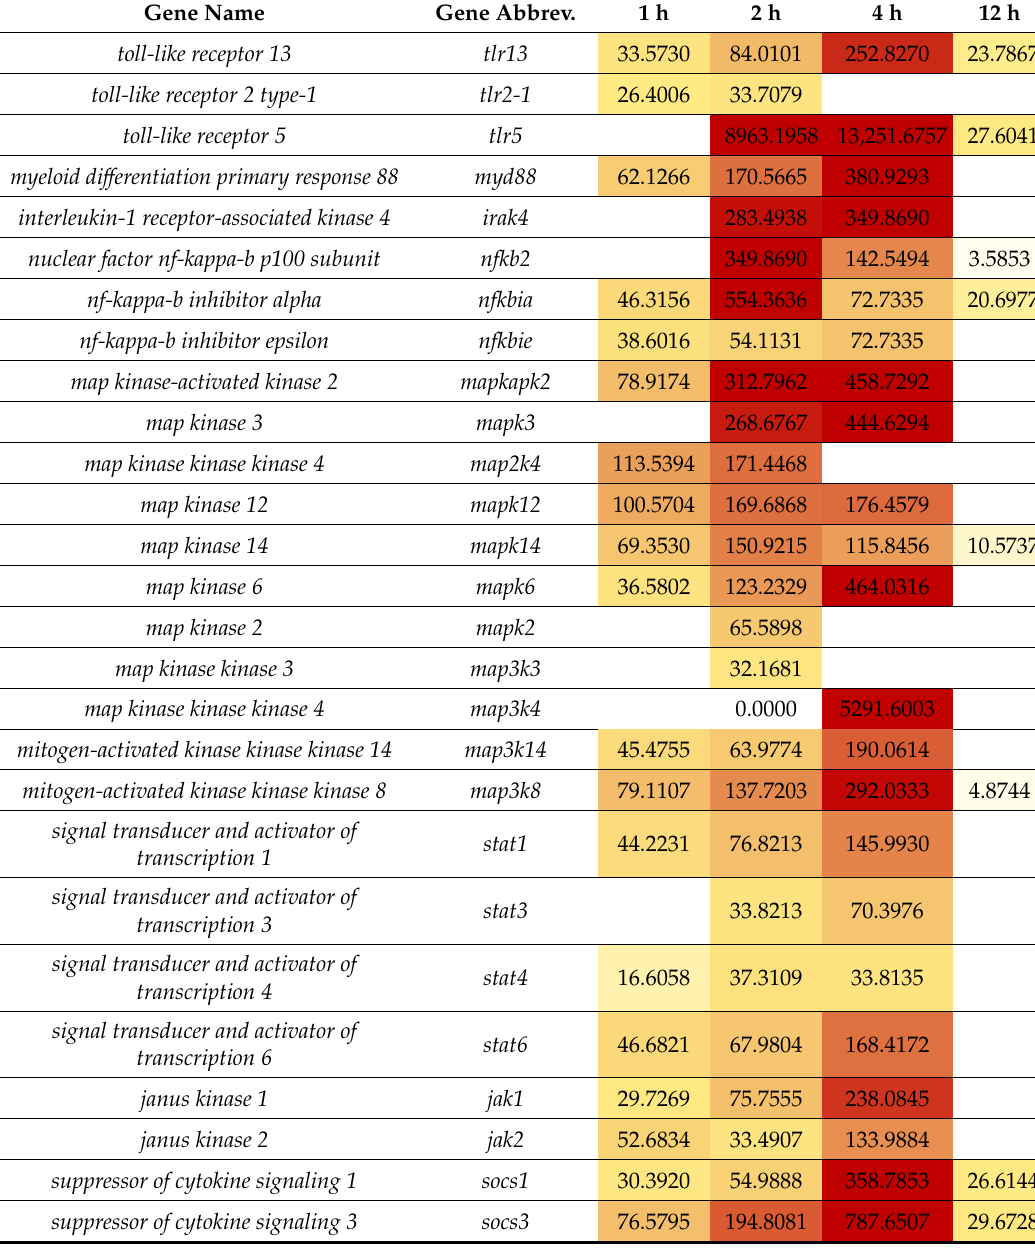
Table 3. Heat map showing a group of DE genes in turbot peritoneal cells at 1, 2, 4 and 12 hpi, including genes coding for toll-like receptors and genes involved in di ff erent signalling pathways. Results are expressed as mean expression ratios of groups 1, 2 and 4 hpi vs. 0 h, or 12 hpi vs. phosphate-bu ff ered saline (PBS). There were no DE genes at 48 hpi. Red indicates increased gene expression levels; green indicates decreased